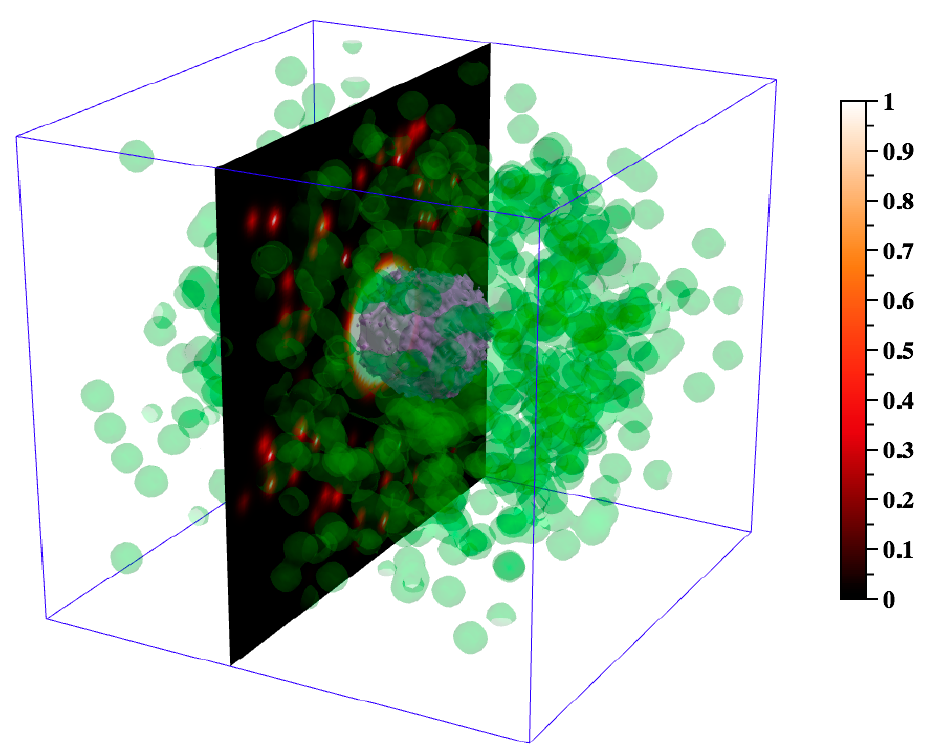
Figure 4. Visualizing the simulated TNF chemical gradient at day 50 post infection for one simulation, using DataTank. This figure depicts the TNF gradient at day 50 using two different methods: (i) a 2D, yz-slice at x = 50, and (ii) 3D level sets. In (i) we show the 2D TNF gradient using the color bar on the right to define concentration intensity. In (ii) we use 3D level sets to depict the 3D spatial distributions of two biologically relevant TNF concentrations for macrophage recruitment. The green 3D surface encloses grid compartments in which the TNF concentration is 0.05 or greater (i.e., level set = 0.05). The 0.05 value represents the minimum concentration that macrophages can sense, and thus a concentration below this value is not detectable by macrophages. The purple 3D surface encloses grid compartments in which the TNF concentration is 50 or greater (i.e., level set = 50). The 50 value represents the maximum concentration that macrophages can sense, i.e., the concentration at which a compartment is considered “saturated” for macrophage sensitivity (~99% saturation according to Michaelis-Menten kinetics).